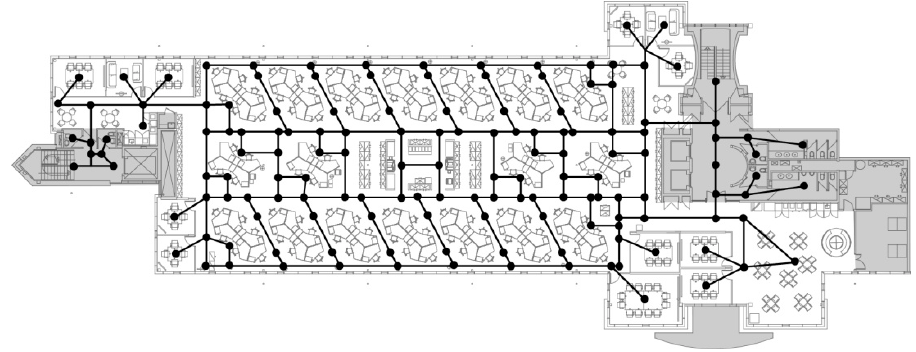
Figure 1. Example of a spatial graph.